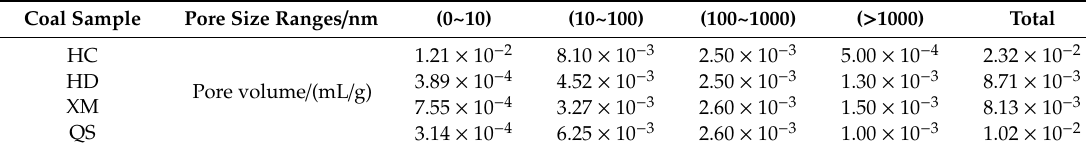
Table 9. Pore volume of coal samples.